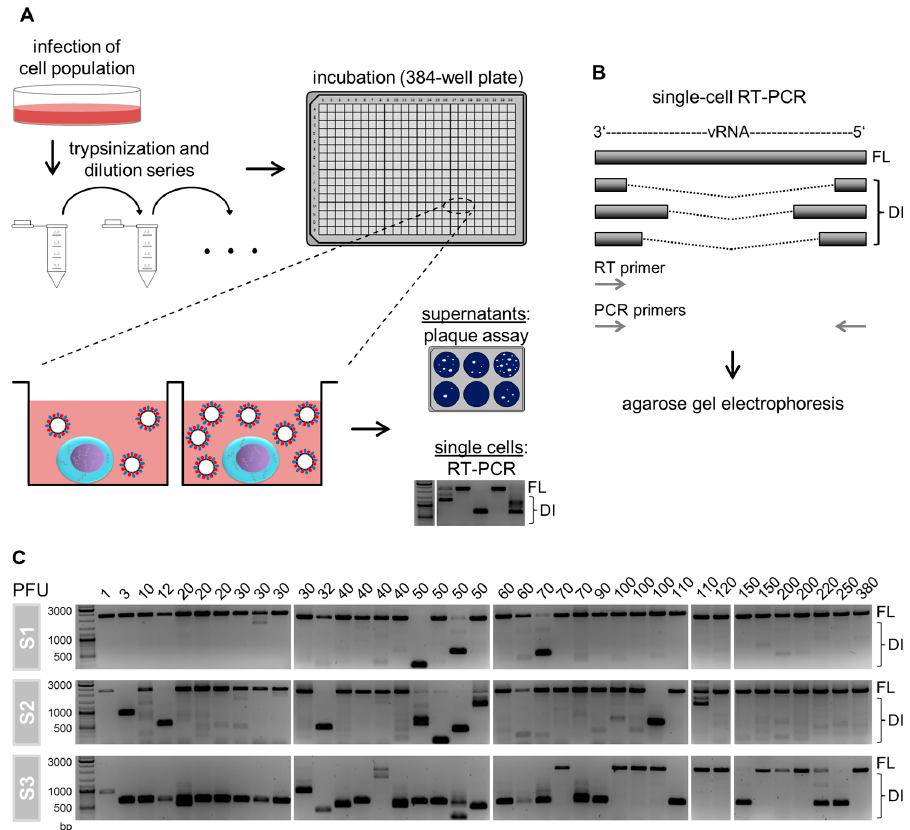
Figure 1. Single-cell analysis approach and cell-to-cell heterogeneity in intracellular defective interfering (DI) viral RNAs (vRNAs). ( A ) Scheme of the experimental procedure. Adherent Madin–Darby canine kidney (MDCK) cells were infected with influenza A virus (IAV) of strain A / PR / 8 / 34 (PR8) at a multiplicity of infection (MOI) of 10. Afterward, the cells were trypsinized, serially diluted, and transferred to a 384-well plate. Single cells in individual wells were identified by phase-contrast microscopy. At 12 hpi, we quantified virus titers in the supernatant of single-cells using the plaque assay. The remaining single cells were lysed and investigated for the presence of intracellular DI vRNAs by reverse transcription polymerase chain reaction (RT-PCR). Illustration adapted from [8,32] . ( B ) Single-cell RT-PCR. DI vRNAs contain large internal deletions of varying lengths and junction points. In RT-PCR, both the RT and PCR primers bind to the terminal 3 ′ and 5 ′ ends of vRNA, which results in their complete amplification. In subsequent agarose gel electrophoresis, DI vRNAs occur as fragments of a reduced size in comparison to the FL vRNAs. ( C ) Intracellular FL and DI vRNAs of IAV-infected single cells. The virus yield of single cells is displayed at the top of the gels. The presence of DI vRNAs was investigated on S1, S2, and S3. The DNA ladder is shown at the left. A total of 39 single cells were analyzed of one representative experiment (out of six independent